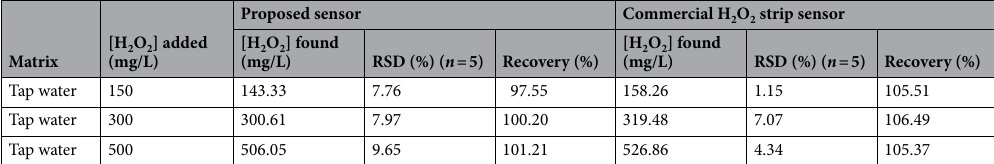
Table 1. Recoveries (%) achieved for [H 2 O 2 ]-spiked sample in tap water via the proposed sensor compared with the commercial strip sensor.